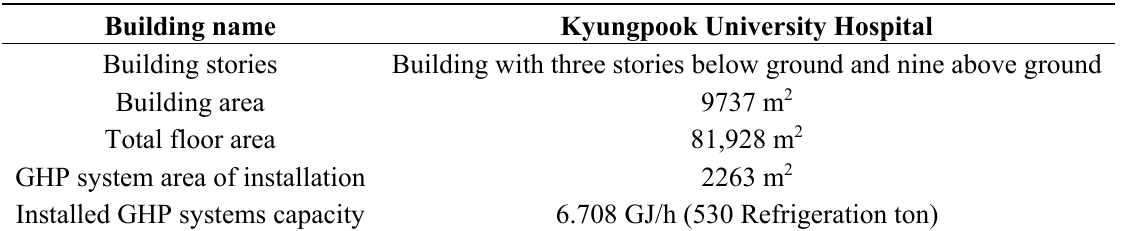
Table 1. Summary of the building information. GHP : geothermal heat